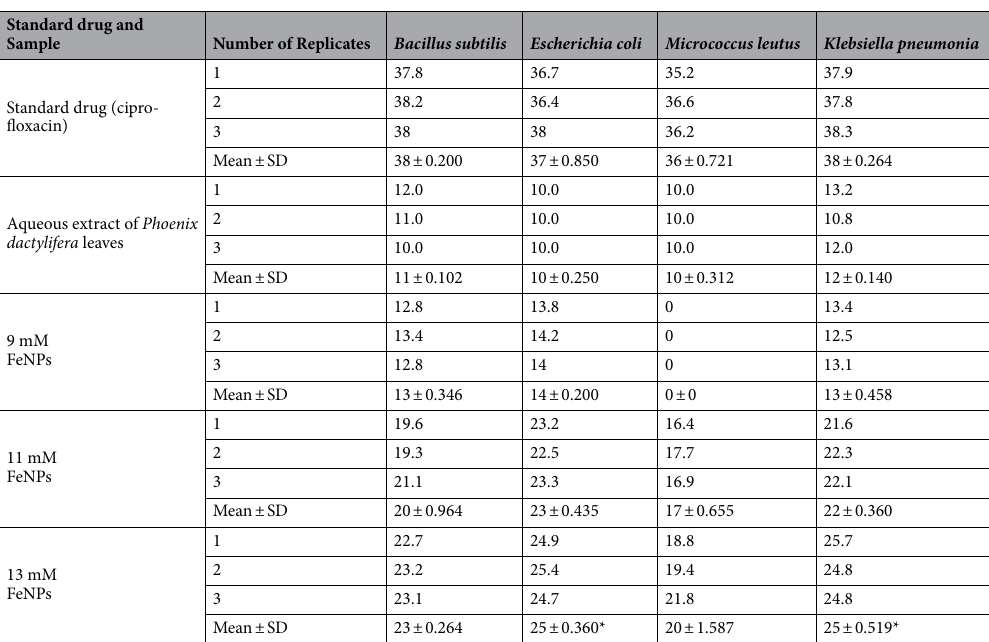
Table 1. Zone of Inhibition of FeNPs synthesized by Phoenix dactylifera. *p value < 0.05 indicates significant results compared to standard.